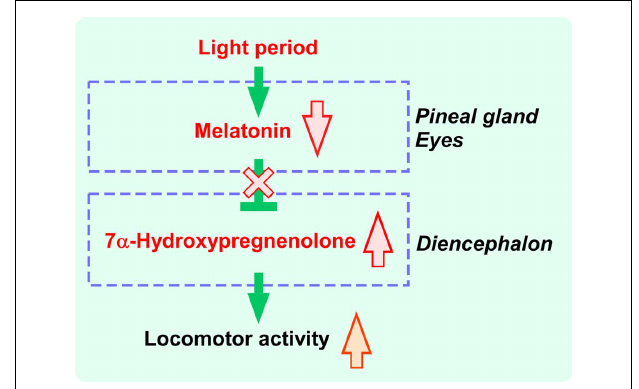
FIGURE 3 | Schematic model depicting the action of melatonin on the regulation of diurnal changes in 7 α -hydroxypregnenolone synthesis and locomotor activity in quail. Melatonin acts to reduce cytochrome P450 7 α expression through melatonin receptor-mediated mechanisms. Melatonin derived from the pineal gland and eyes regulates 7 α -hydroxypregnenolone synthesis in the brain, thus inducing diurnal locomotor changes. See the text for details.